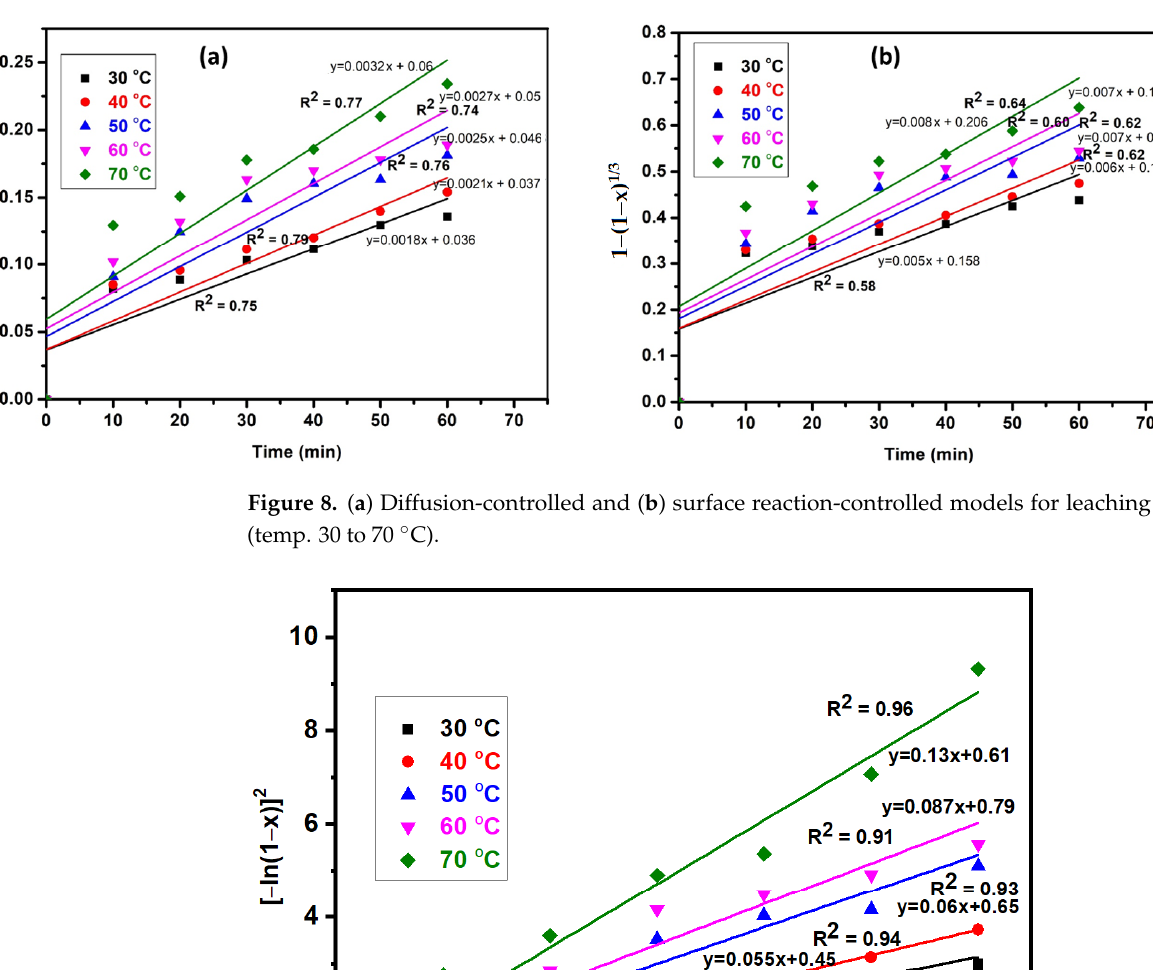
Figure 10. Arrhenius plot for the empirical kinetic model for gold. 3.3. Liquid–Liquid Extraction and Separation of Gold from Leach Liquor Liquid–liquid extraction (solvent extraction) was carried out for extraction of gold from the leached solution using 0.1 M 3° amide as a reagent and 1 M sodium hydroxide as stripping reagent. The strip solution consists of gold with the purity of 99% after the